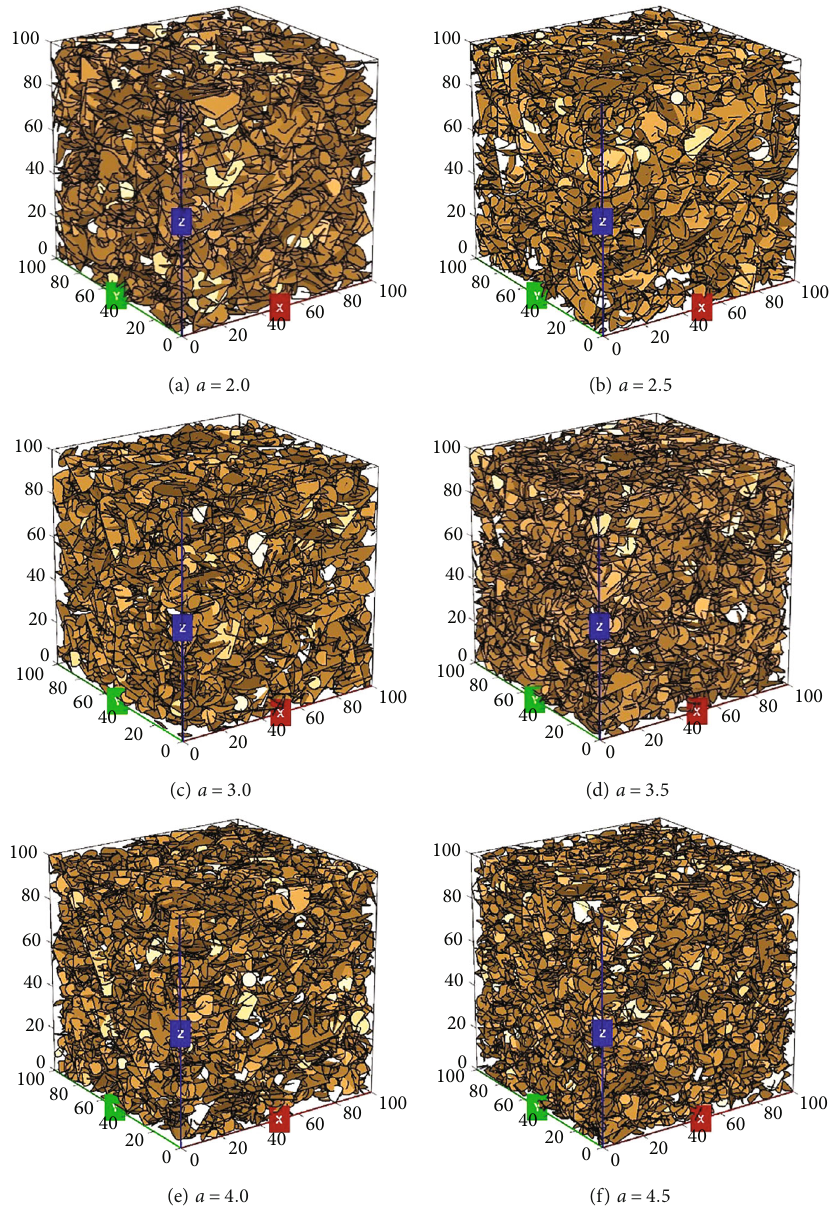
Figure 6: Three-dimensional DFN model with di ff erent a